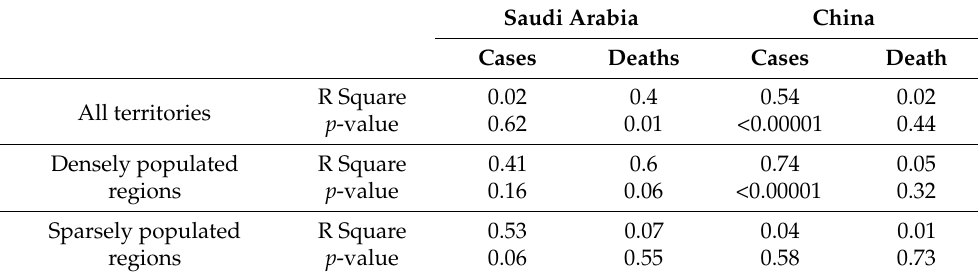
Table 1. Coefficients of determination and p